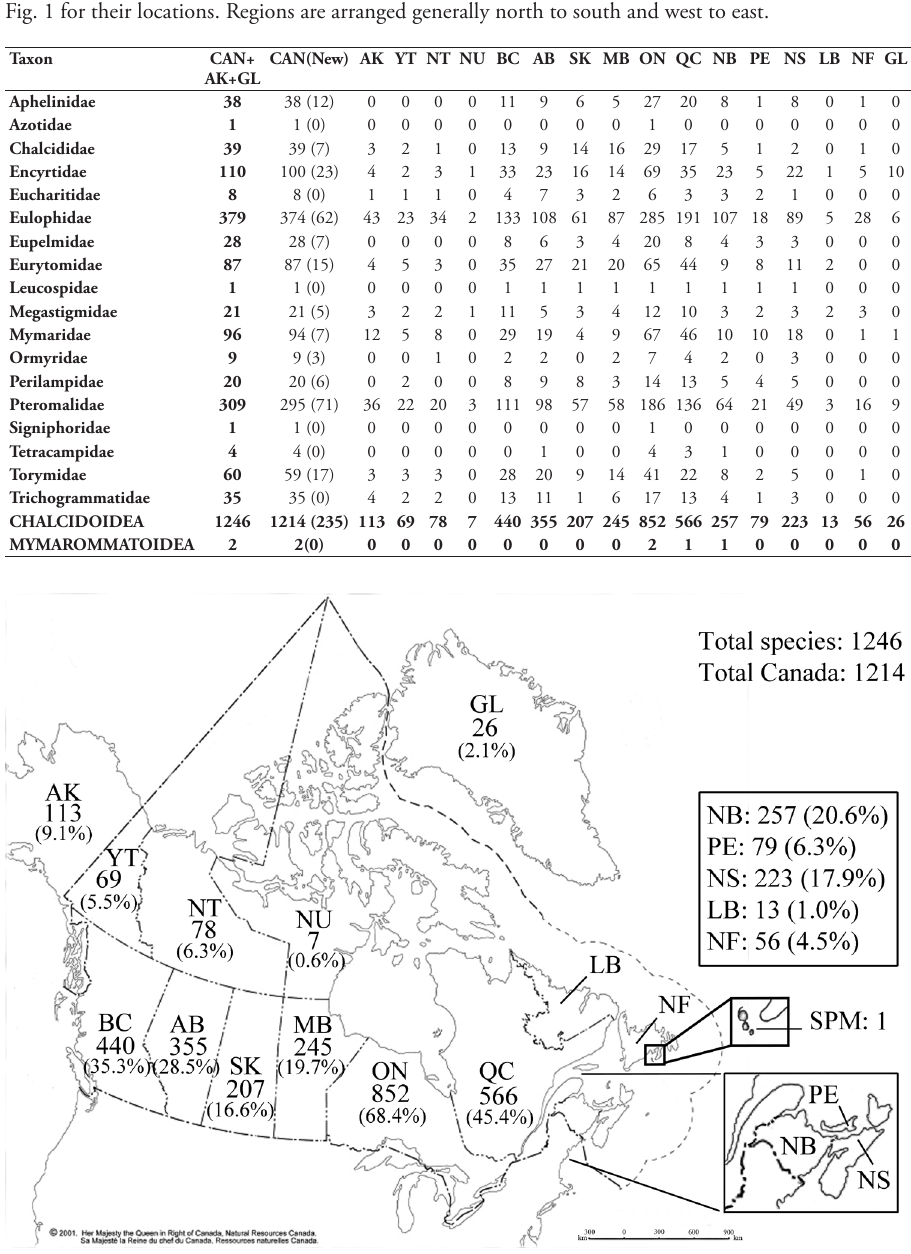
Figure 1. Map of Canada, Alaska, Greenland, and Saint Pierre and Miquelon showing number of de- scribed, recorded Chalcidoidea species and percentage of total species for each region. Canada is com- prised of all regions except for Alaska, Greenland, and Saint Pierre and Miquelon. See the Presentation of data section under Methods for the acronyms of the regions treated in the